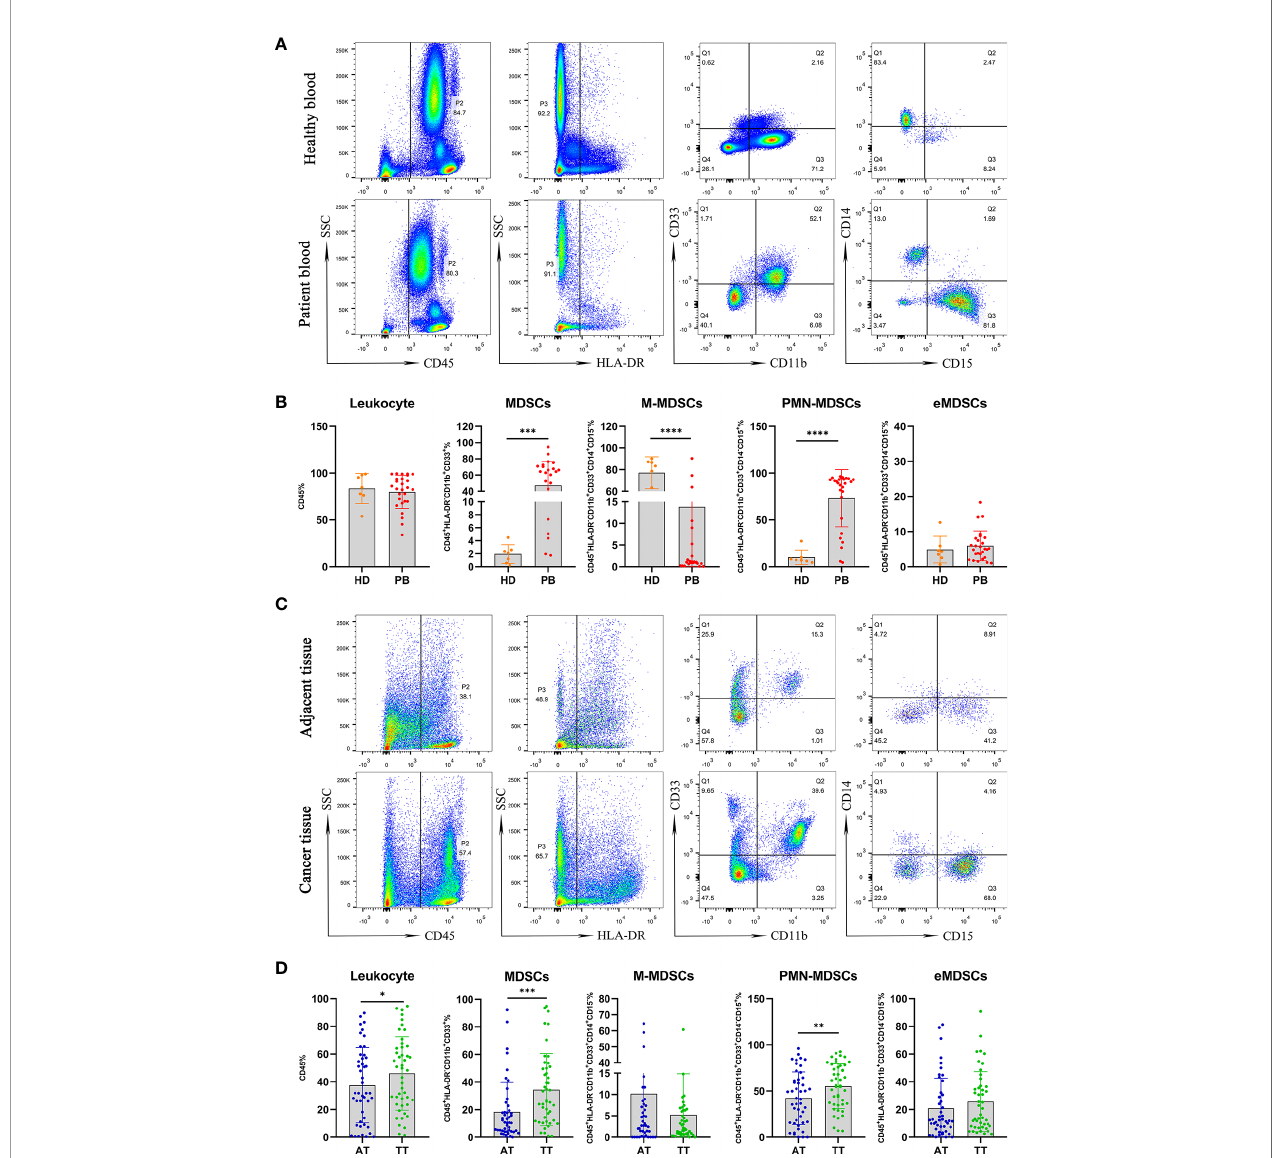
FIGURE 2 | Mononuclear cells obtained from peripheral blood of AEG patients (n =27) and HD (n = 7) were assessed by multicolor fl ow cytometry. Mononuclear cells were stained for MDSCs using fl uorochrome-labeled antibodies against CD45, HLA-DR, CD11b, CD33, CD14, CD15. A morphological gate of mononuclear cells based on SSC and SFC properties were applied before gating for MDSCs subsets. Markers analyzed are indicated in the axis of each fl ow cytometry graphs. Representative dot plots of leukocyte (CD45 + cells), MDSCs (CD45 + HLA-DR − CD11b + CD33 + cells) and three subsets of MDSCs, including monocytic (M)-MDSCs (CD45 + HLA-DR − CD11b + CD33 + CD14 + CD15 − cells), polymorphonuclear (PMN)-MDSCs (CD45 + HLA-DR − CD11b + CD33 + CD14 − CD15 + cells), and early-stage PMN-MDSCs, and eMDSCs in the PB and HD are presented as the percentage within the total respective subset (B) . Comparative analysis of levels of leukocyte and MDSCs in AT (n = 46) and TT (n = 46) from AEG patients. Representative fl ow cytometric plots show leukocyte, MDSCs, and three subsets of MDSCs in AT and TT of AEG patients (C) . Cumulative scatter plots show the percentage of leukocyte, MDSCs, M-MDSCs, PMN-MDSCs, and eMDSCs in the AT and TT, which are presented as the frequency within the total respective subset (D) . Each point corresponds to an individual patient or a HD. Column graphs show the mean ± standard error of the mean (SEM). Asterisks represent statistical signi fi cance (*p < 0.05; **p < 0.01; ***p < 0.001; ****p <